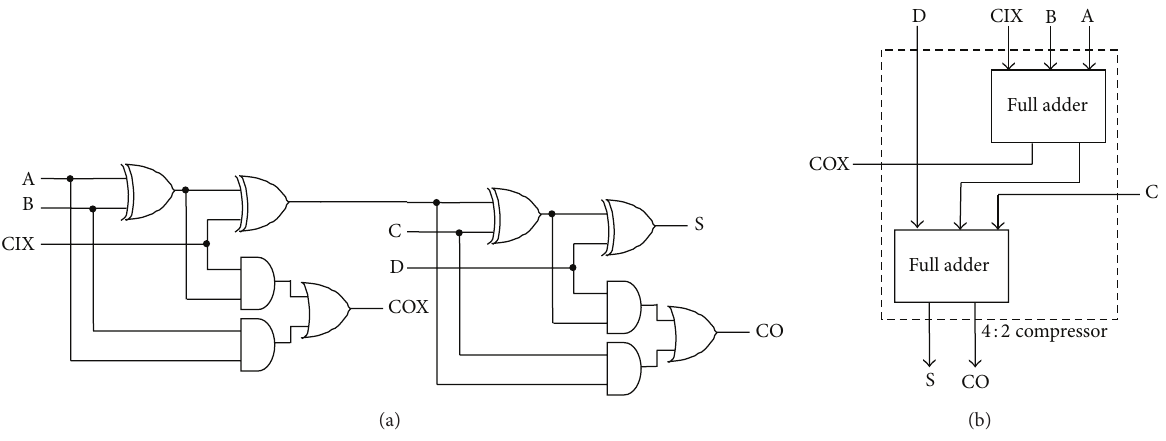
Figure 2: (a) Neil and Harris compressor architecture [7]. (b) Compressor architecture using full adder